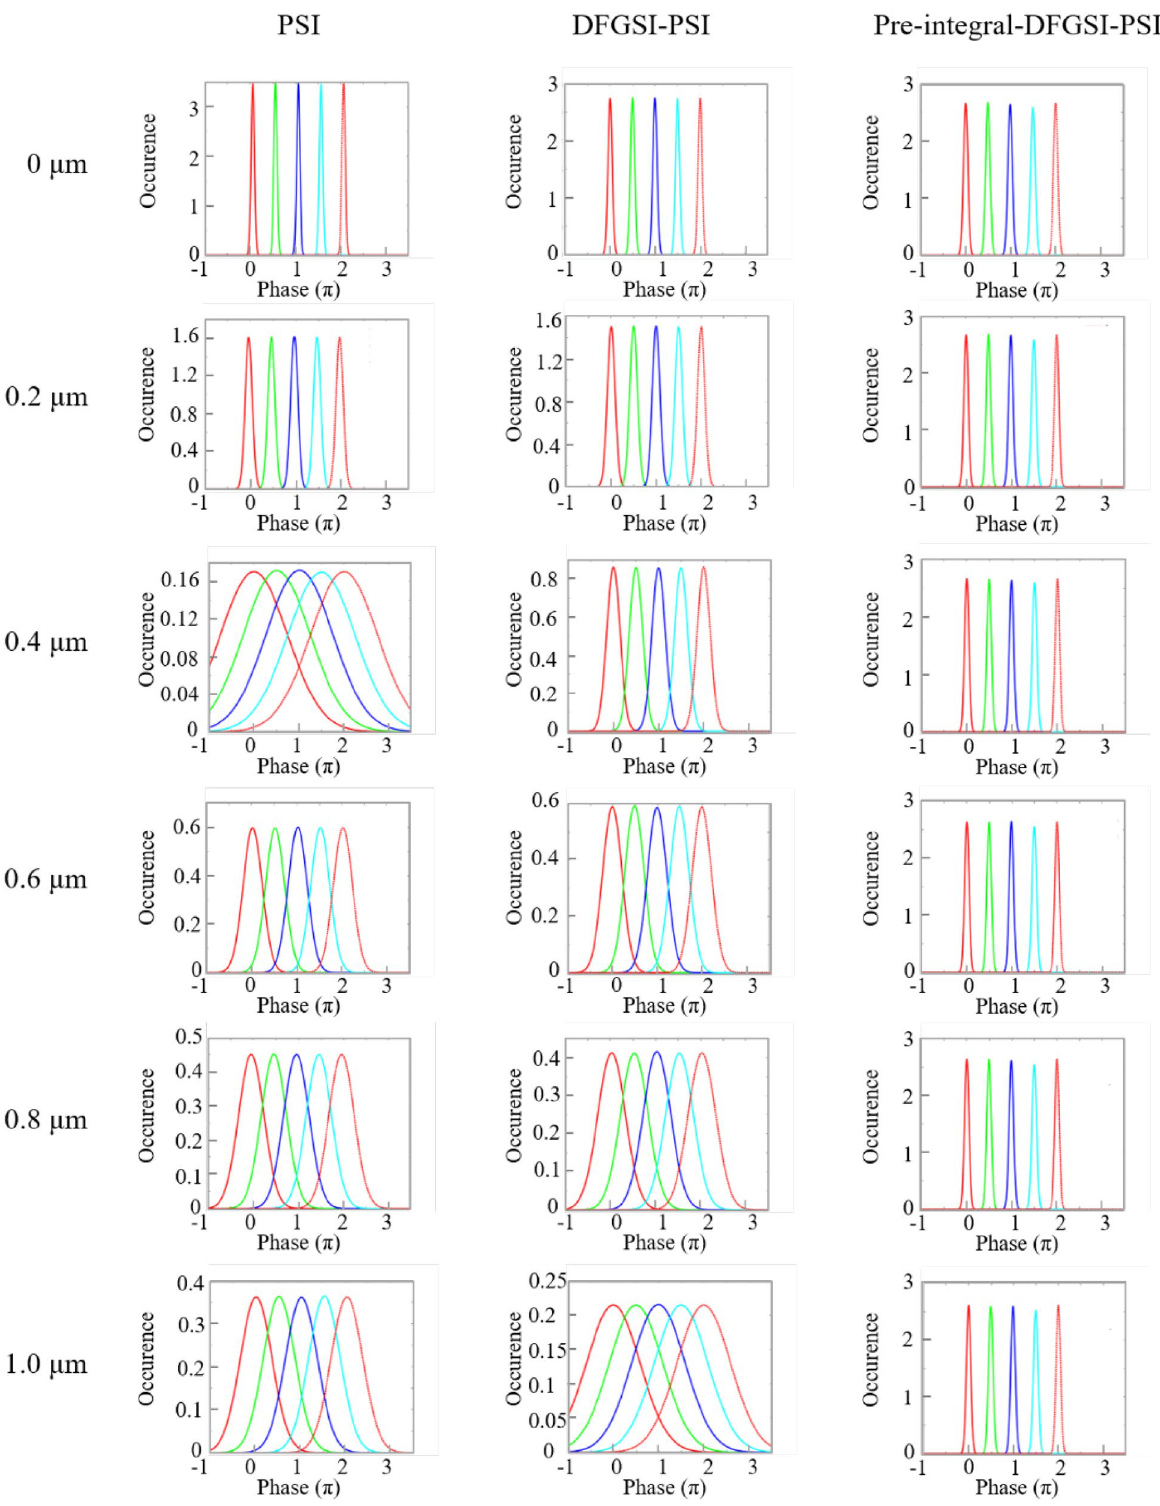
Figure 5. Simulation for the decoded phase signals of the PSI, DFGSI-PSI, and pre-integral-DFGSI-PSI under different disc rotation amounts of 0 μm, 0.2 μm, 0.4 μm, 0.6 μm, 0.8 μm, and 1.0 μm. Where the horizontal axis of each picture is retrieved phase, the vertical axis of each picture is the count of occurrence, the bright-red curve is the histogram for the coding signal 0, the green curve is the histogram for the coding signal 0.5π, the deep-blue curve is the histogram for the coding signal π, the light-blue curve is the histogram for the coding signal 1.5π, and the light-red curve is the histogram for the coding signal